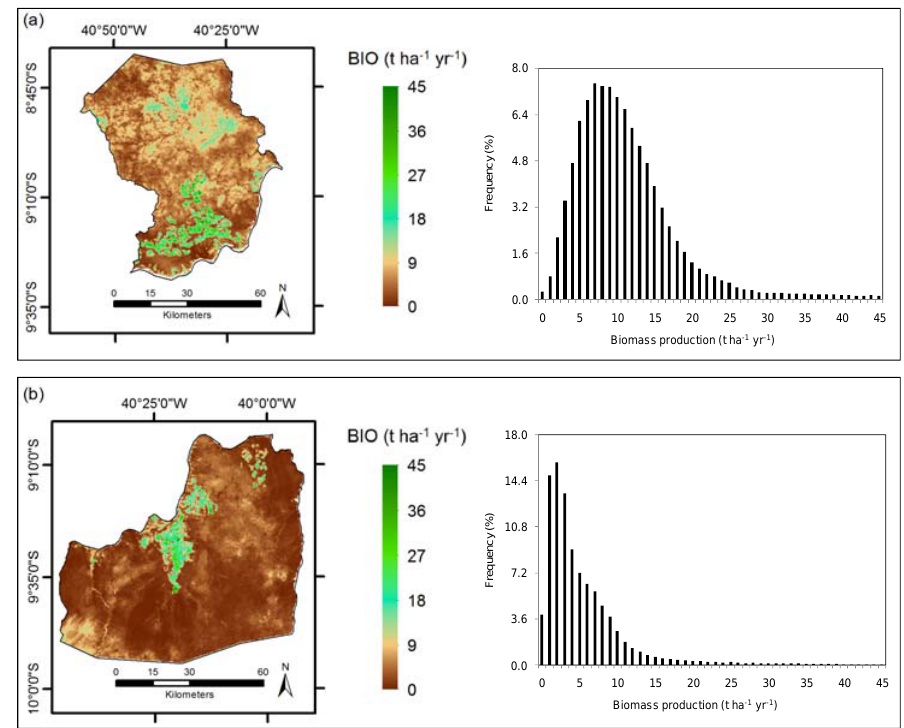
Figure 6. Annual values and histograms for biomass production (BIO) in the Brazilian semi-arid agricultural growing regions: ( a ) Petrolina municipality, Pernambuco (PE) state; ( b ) Juazeiro municipality, Bahia (BA)